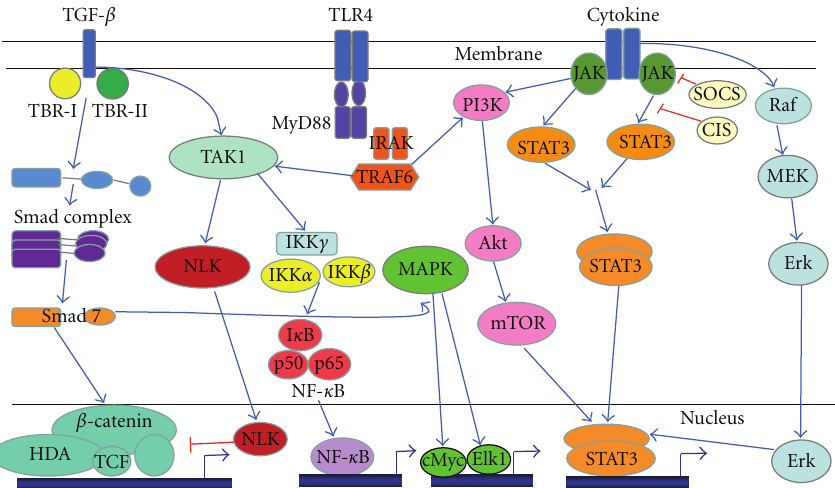
Figure 2: The JAK/STAT3 signaling pathway transmits information from cytokine/chemical signals outside the cell, through the cell membrane, and into the gene promoters on the DNA in the cell nucleus, which causes DNA transcription and activity in the cell. After JAK is activated by autophosphorylation, STAT3 protein then binds to the phosphorylated receptor. STAT3 is phosphorylated and translocated into the cell nucleus, where it binds to DNA and promotes transcription of genes responsive to STAT. TGF- β controls proliferation, cellular di ff erentiation, and it acts as an antiproliferative factor in normal epithelial cells, and at early stages of oncogenesis. In the SMAD pathway, the TGF- β dimers bind to a type-2 receptor which recruits and phosphorylates a type-1 receptor. The type-1 receptor then recruits and phosphorylates a SMAD. This SMAD then binds to the common SMAD and forms a heterodimeric complex. This complex then enters the cell nucleus where it acts as a transcription factor for the various genes, including those to activate the MAP Kinase pathway, which triggers apoptosis. The TAK1-NLK-STAT3 pathway cascade participates in TGF- β -mediated mesoderm induction. Finally, MyD88 is a universal adaptor protein that is used by most of TLRs to activate the transcription factor NF- κ B. These signals are closely associated with colitis- associated cancer formation. The abbreviations used in this figure are: Erk, extracellular signal-regulated kinases ( = MAPK); HAD, histone deacetylase; IKK, I κ B inhibitor; IRAK, IL-1 receptor associated kinase; JAK, Janus kinase; NLK, nemo-like kinase; MAPK, microtubule- associated protein kinase; MEK, mitogen activated protein kinase; mTOR, mammalian target of rapamycin; MyD88, myeloid di ff erentiation primary response gene 88; PI3K, phosphoinositide 3-kinase; STAT, signal transducer and activator of transcription; TAK, TGF- β activated kinase; TBR, TGF- β receptor; TCF, T cell factor; TGF, transforming growth factor; TLR, Toll-like